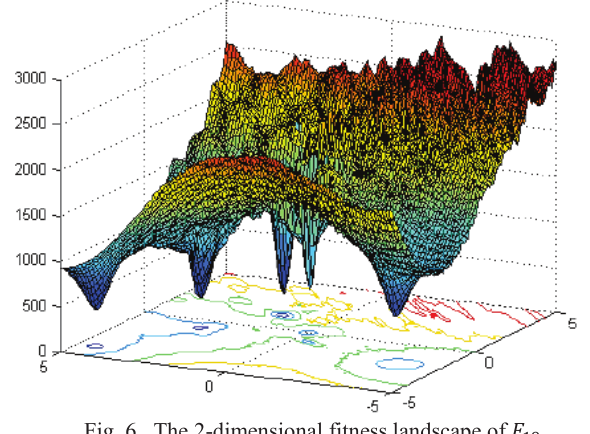
Fig. 5. The 2-dimensional fitness landscape of